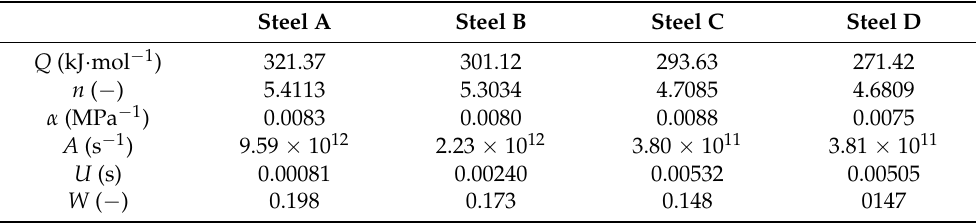
Figure 4. Calculation of material constants in Equations (7) and (6) for steel B: ( a ) calculation of n = 5.667; ( b ) calculation of β = 0.051; ( c ) calculation of Q = 341 kJ · mol − 1 ; ( d ) determination of W = 0.173. Table 3. Determined material constants intended for prediction of σ p and ε p of investigated steels according to Equations (5) and (6).